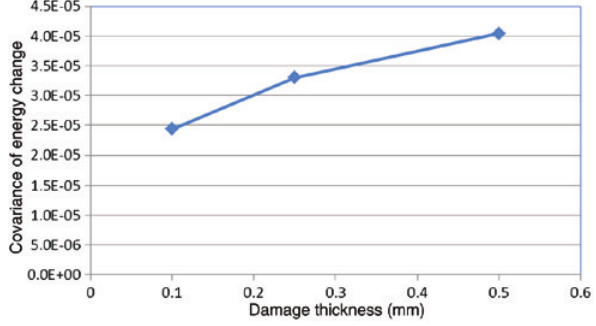
Figure 20: Covariance of energy change with varying delamination thickness size for full